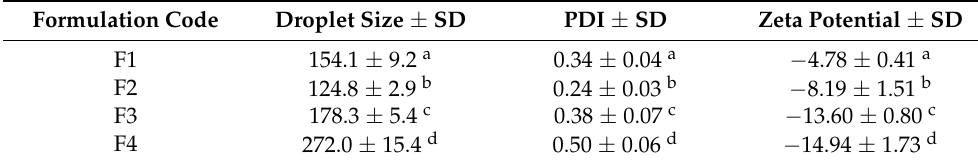
Table 2. Characterization of selected ETO-NE.